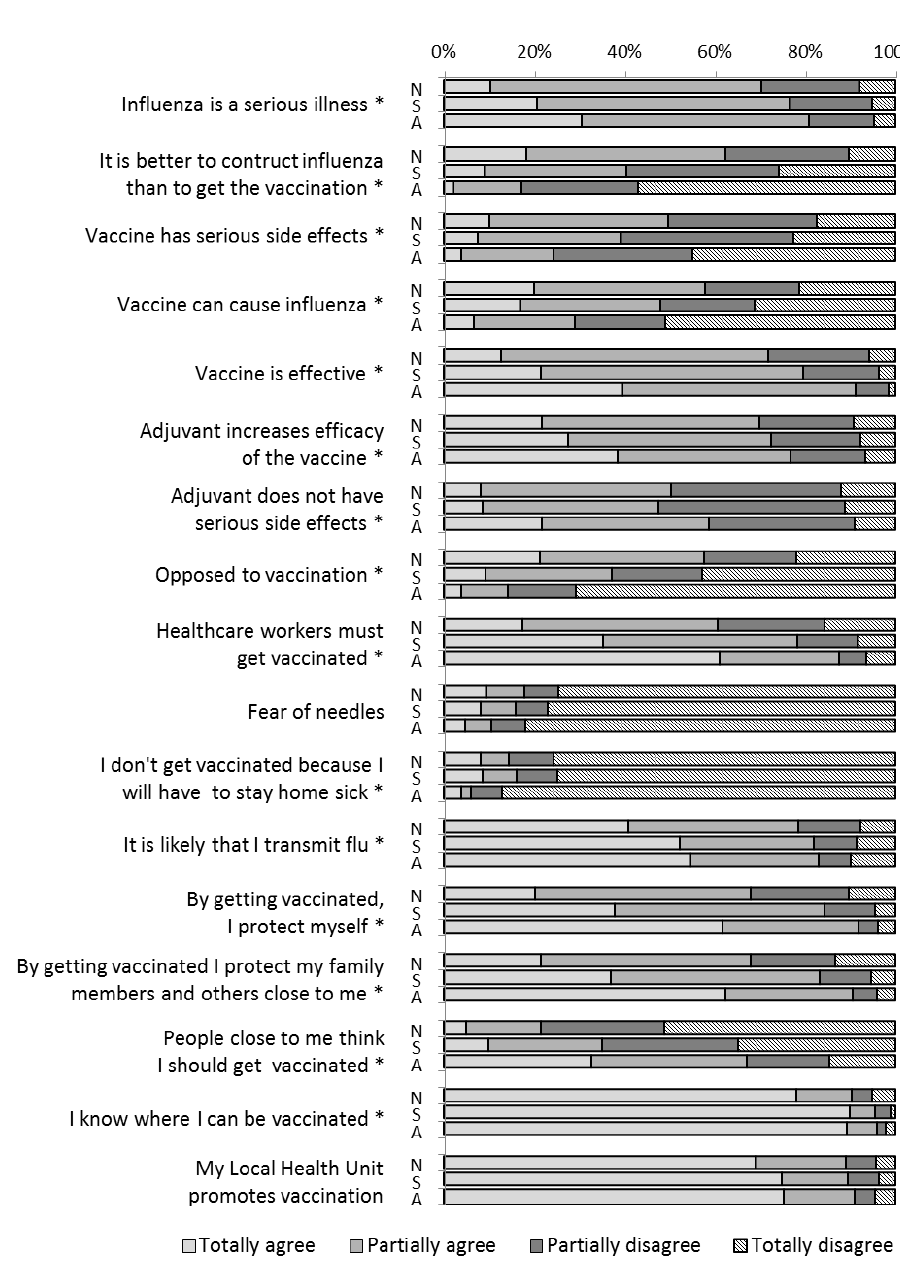
Figure 1. Agreement or disagreement with factual statements regarding influenza, influenza vaccination, and vaccines in the “never vaccinated” (N), “sometimes vaccinated” (S), and “always vaccinated” (A) subgroups. * p <